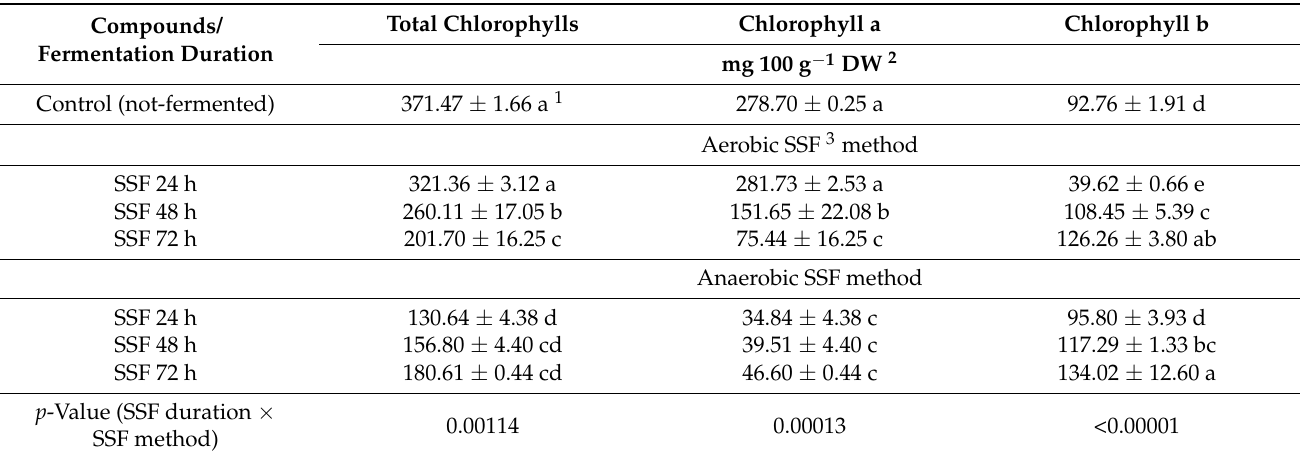
Table 3. The contents of total chlorophylls, chlorophyll a and chlorophyll b in willow herb leaves fermented under the different fermentation methods and